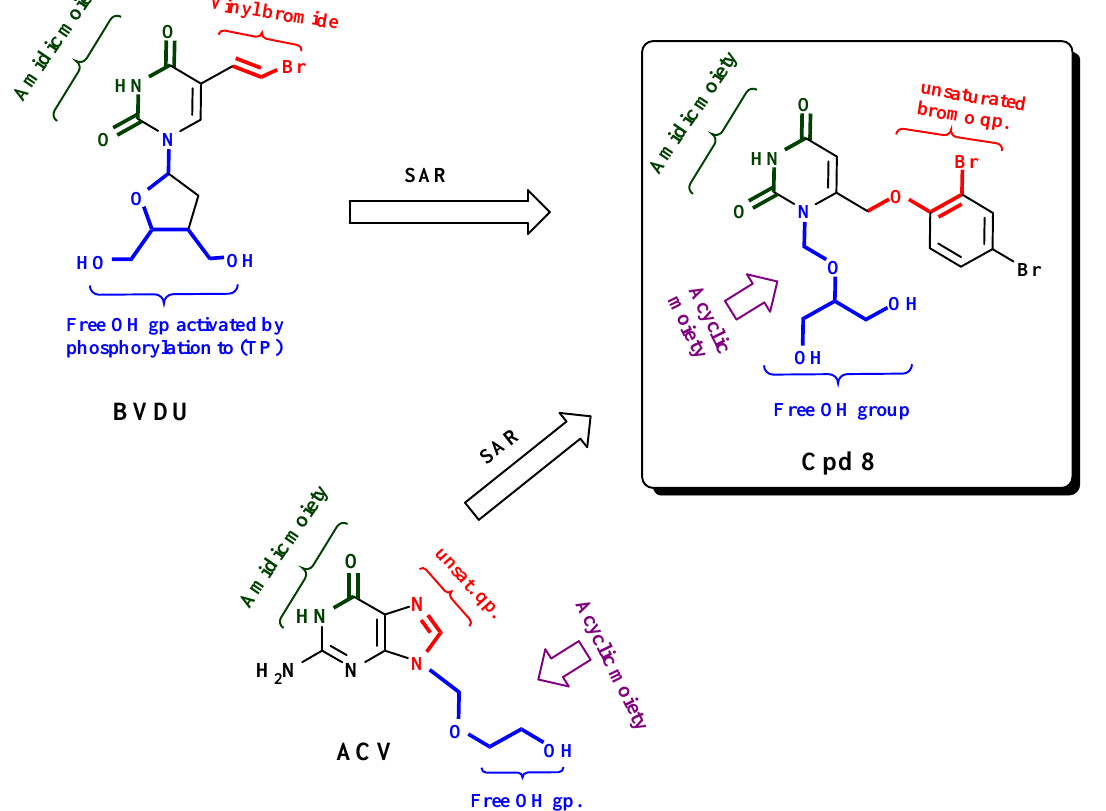
Figure 4. SAR relation between active compounds and reference drug (Acyclovir).